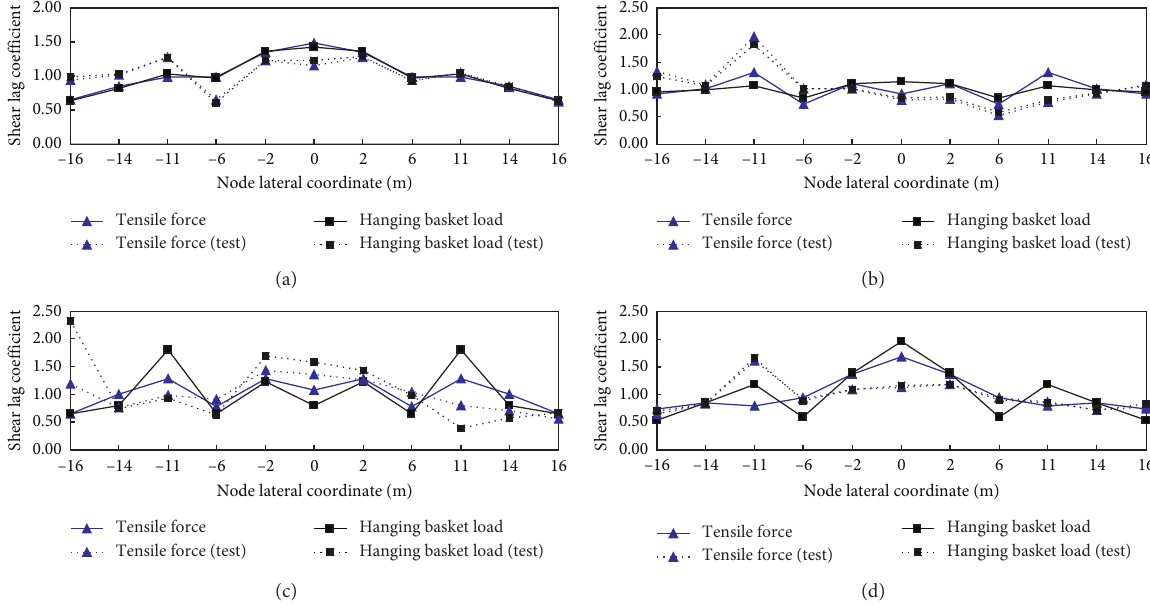
Figure 9: Contrast diagram of shear lag coefficient in G1-G4 (Condition 4): (a) G1 section, (b) G2 section, (c) G3 section, and (d) G4